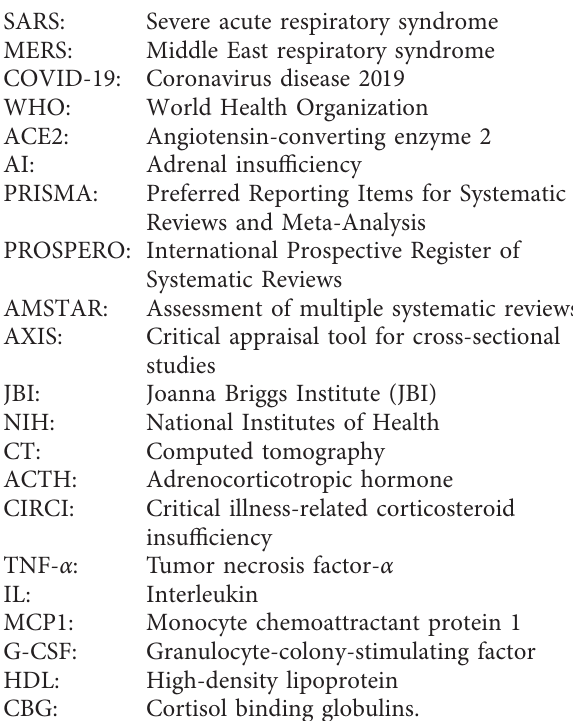
Table S1: risk of bias assessment of cross-sectional studies. Table S2: risk of bias assessment of case report